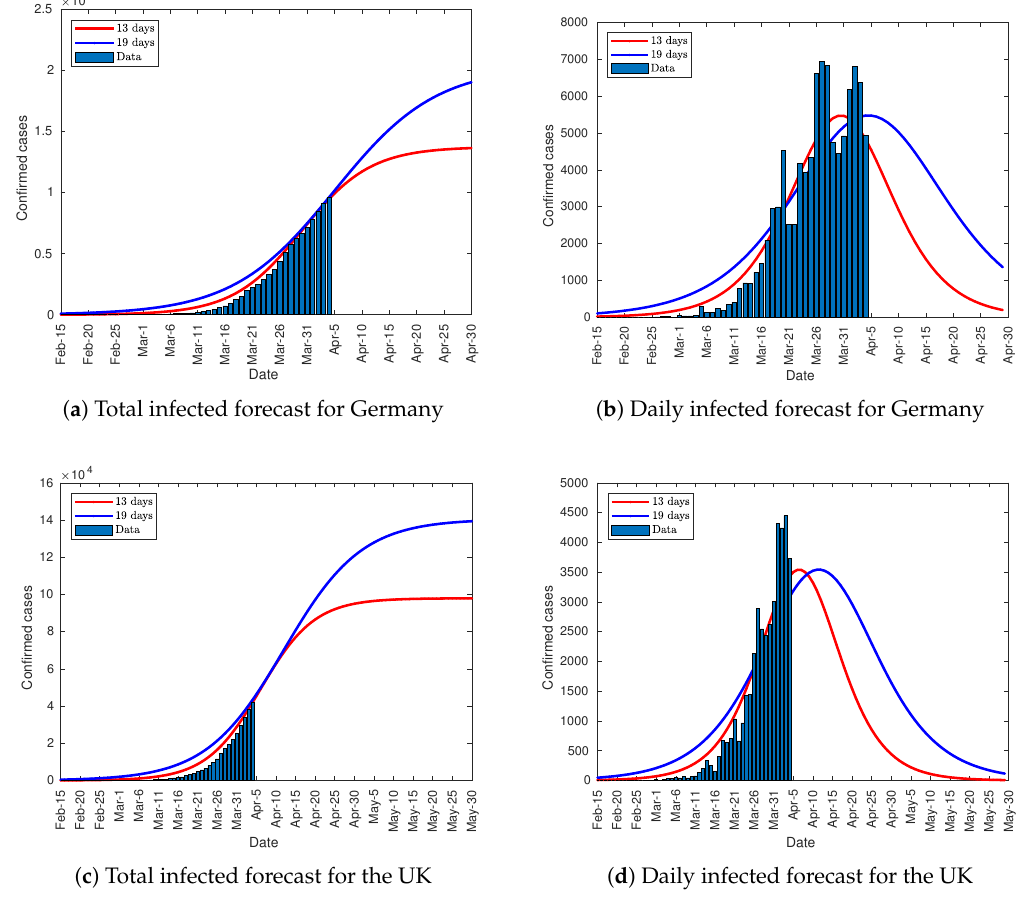
Figure 16. Total and daily infected forecasts. Table 3. Forecast of the total number of COVID-19 infections for Spain, Italy, France, Germany and the